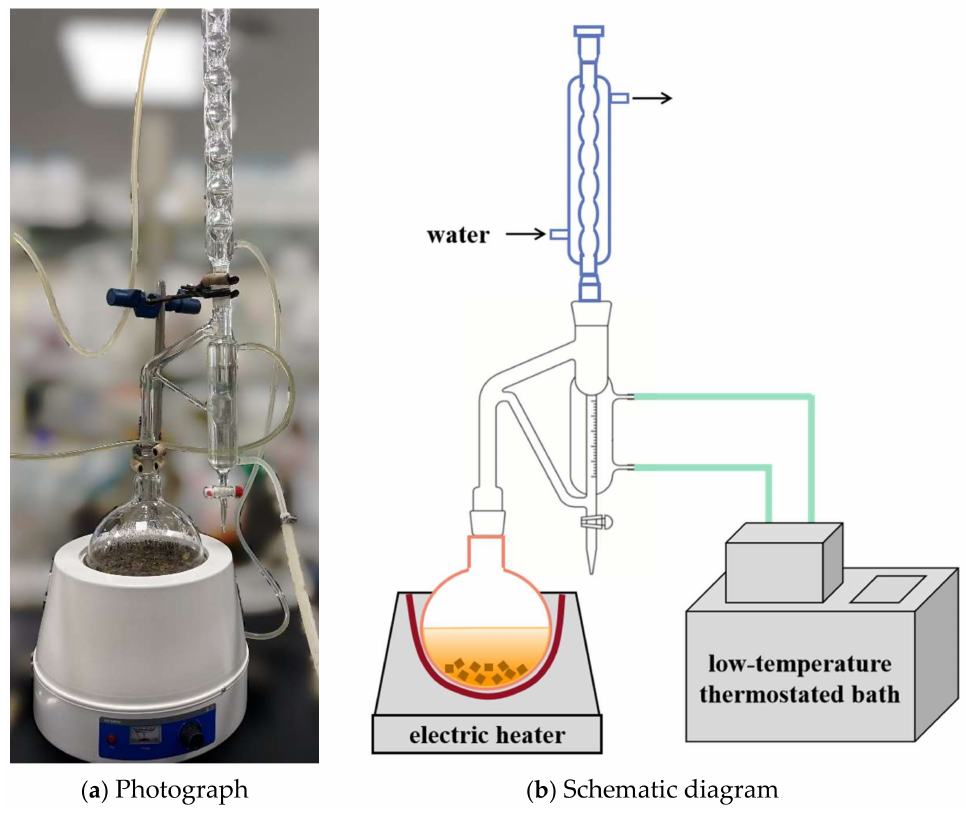
Figure 1. Experimental device for steam